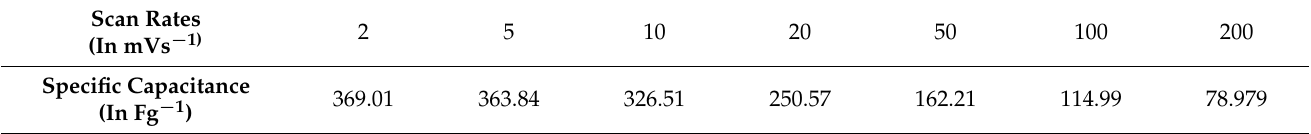
Table 1. Specific capacitance calculated using CV plots of the thin electrode device.